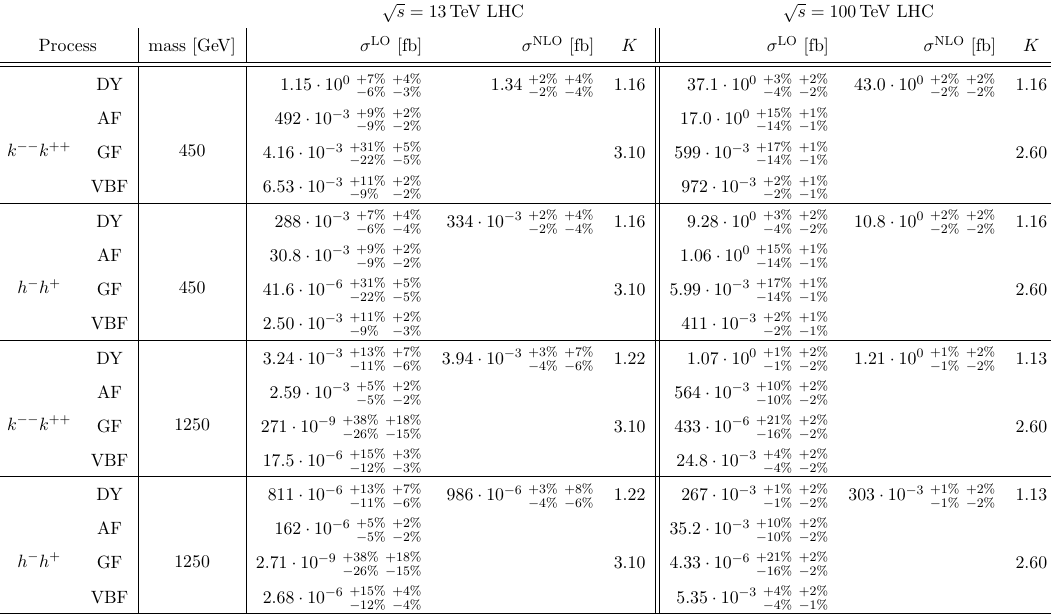
Table 3 . For representative masses m k , m h [GeV] (column 2), the predicted cross sections [fb] at LO and/or NLO in QCD for inclusive pp → k −− k ++ + X (rows 1 and 3) and pp → h − h + + X (rows √ 2 and 4) production at s = 13 TeV (column 3) and 100 TeV (column 4), for the Drell-Yan process (DY), photon fusion (AF), gluon fusion (GF), and EW vector boson scattering (VBS). Also shown are scale uncertainties [%], PDF uncertainties [%], and QCD K -factor (if present). Cross